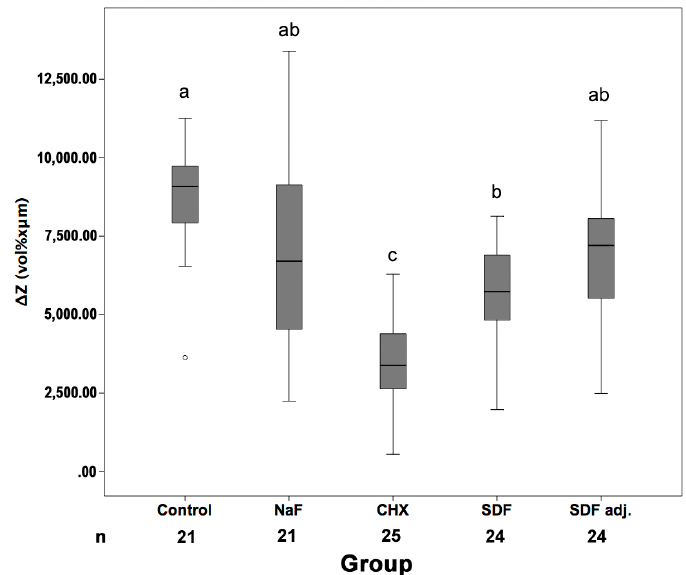
Figure 1. Mineral loss of root carious lesions in different groups. Samples were submitted to no treatment (Con), daily sodium fluoride (NaF) rinses only, chlorhexidine (CHX) or silver diamine fluoride varnishes plus daily NaF rinses. For SDF, artifact-adjusted (SDF adj ) and unadjusted (SDF) values are reported. Line and box: Median and 25th/75th percentiles; whiskers: Range; circles: Outliers. Different superscript letters indicate statistically significant differences between groups ( p < 0.05, Mann–Whitney/Bonferroni) (for example, NaF (superscript letter ab) is significantly different to CHX (subscript letter c) but not significantly different to the other groups (subscript letters ab, a or b)). n: Number of samples available for determining Δ Z.